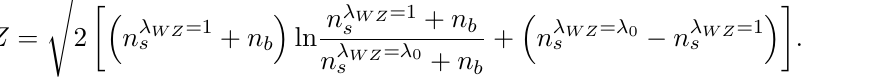
1 : 64, assuming the (cid:20)